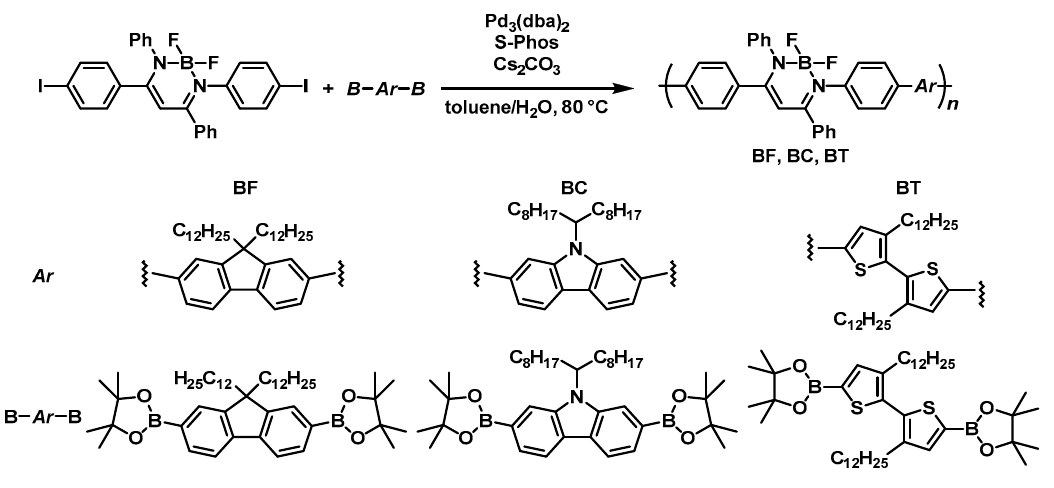
Scheme 1. Synthetic schemes of the polymers containing boron diiminate. Table 1. Polymer properties of the products a . Table 1. Polymer properties of the products a